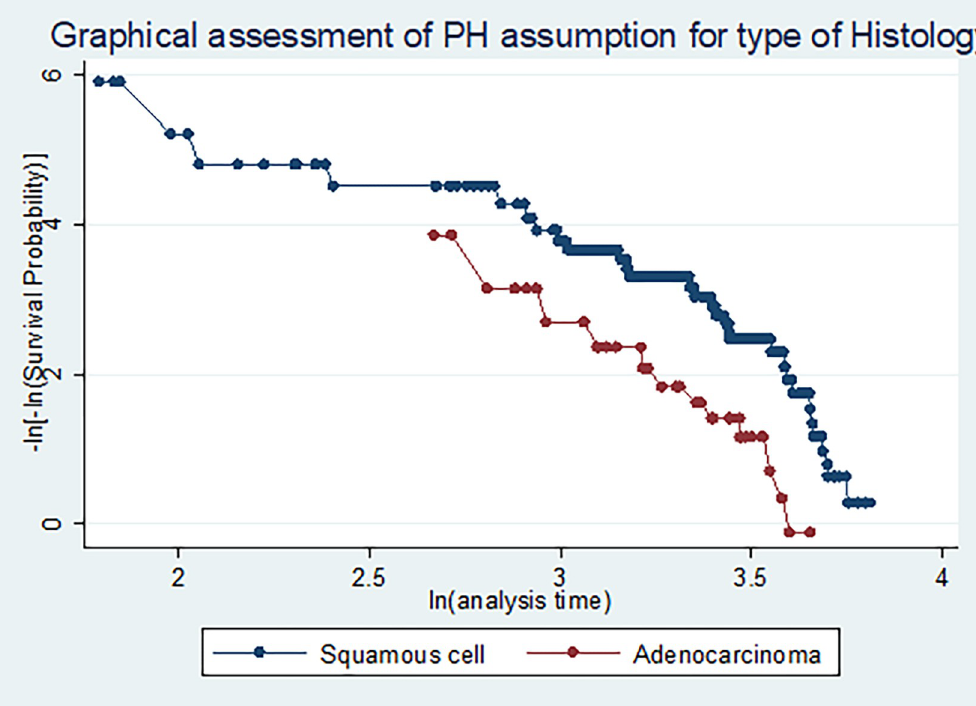
Fig 7. Figure graphical assessment of assumption of proportional-hazards for types of histology.